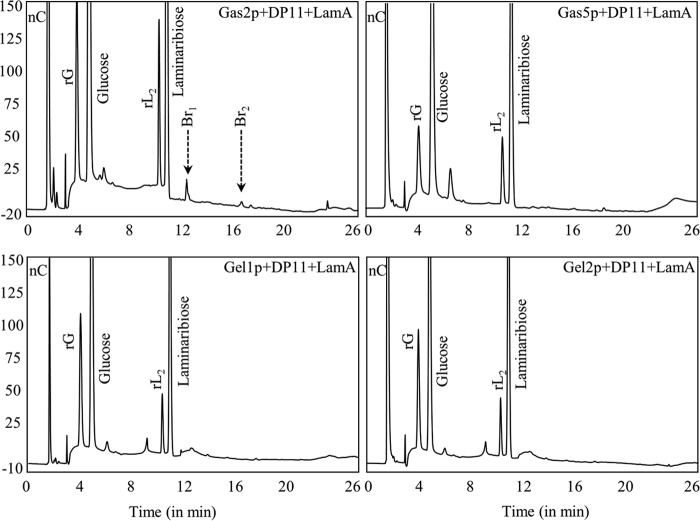
Dual elongating-branching activity was associated with a putative CBM, CBM43. Similar to ScGas1p and AfGel4p, ScGas2p, but not ScGas5p, AfGel1p, or AfGel2p, showed elongating-branching activity. ScGas1p, ScGas2p, and AfGel4p, but not ScGas5p, AfGel1p, and AfGel2p, are characterized by the presence of a CBM (CBM43), suggesting that the dual elongating-branching activity is associated with glycosyltransferases with a putative CBM, CBM43 (gradient run II; rG/rL2; see Fig. 4).